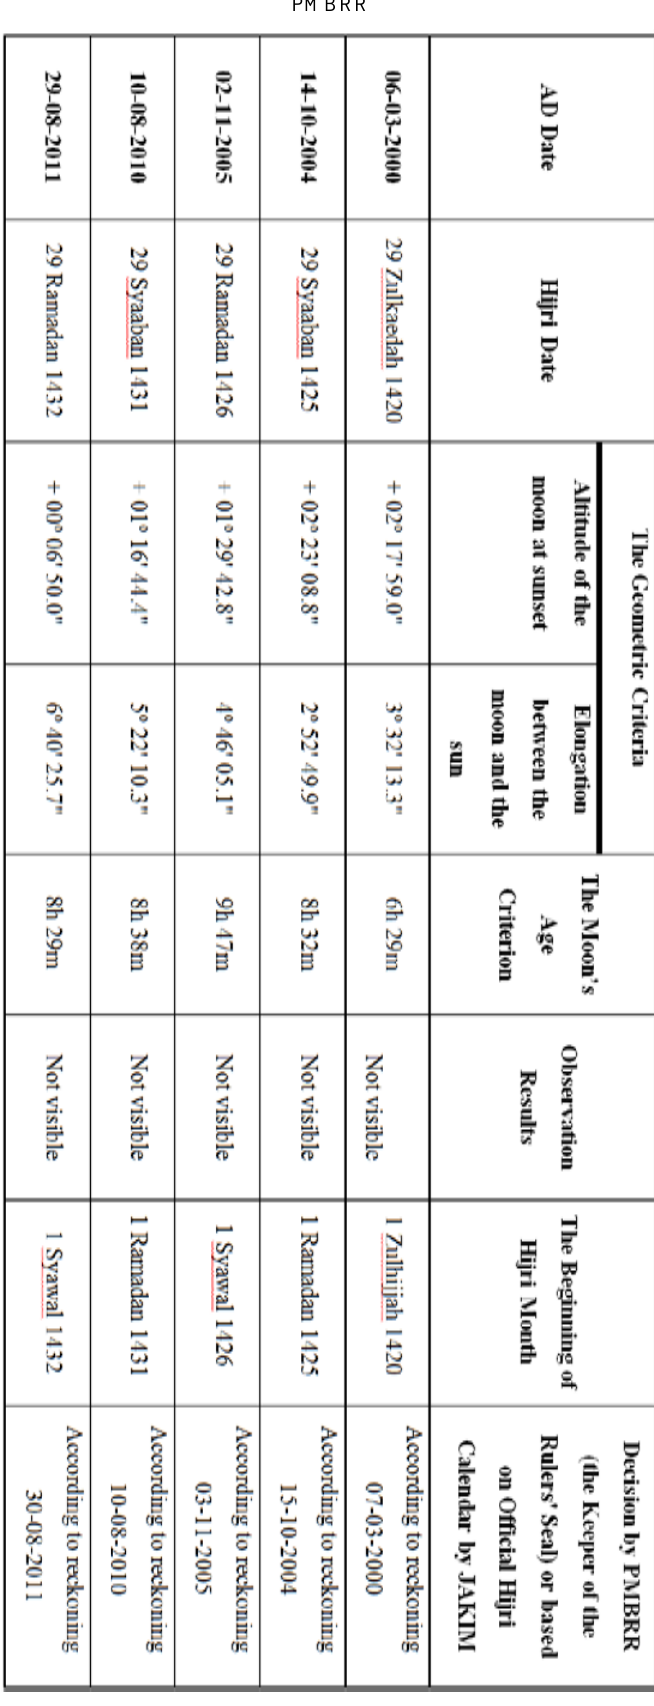
Table 2. The decided date for the beginning of the month of Ramadan, Syawal and Zulhijjah according